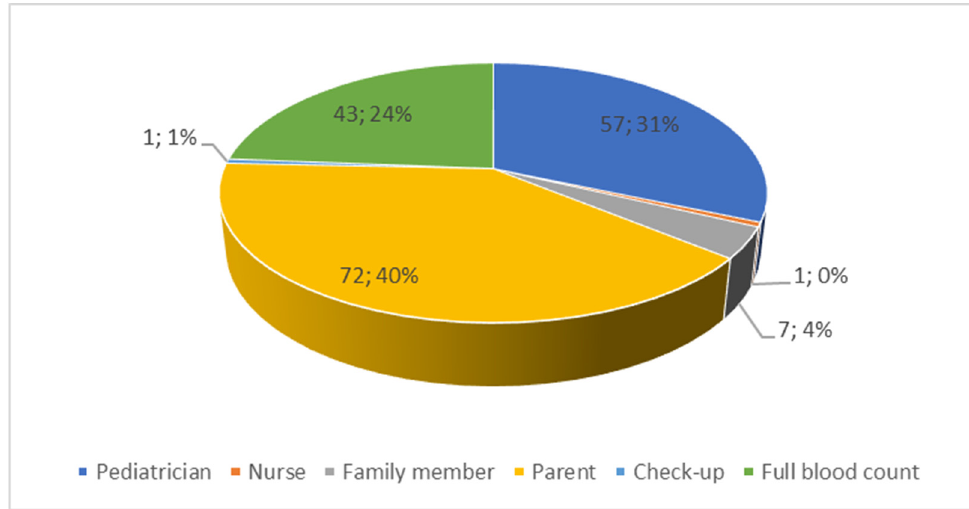
Figure 2. Recognition of the first symptoms in the child.